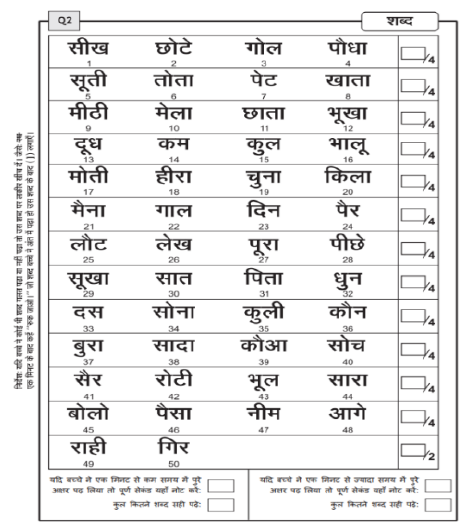
Figure 3: Sample Hindi reading test of 50 words The participants were given 60 seconds for every exer-